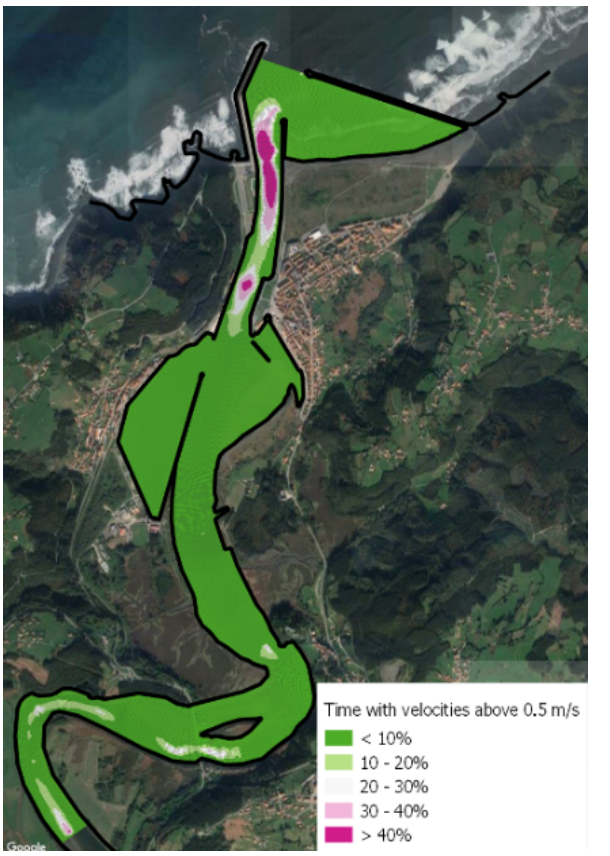
Figure 5: Annual potential